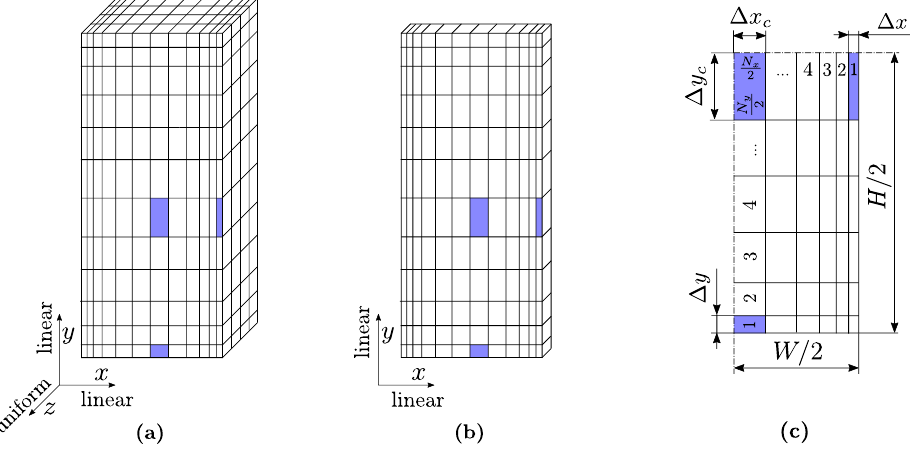
Figure 5. Spatial discretization of the computational domain and mesh refinement strategy: ( a ) 3D mesh for Large Eddy Simulation (LES) and ( b ) 2D mesh for Unsteady Reynolds-Averaged Navier– Stokes (URANS). ( c )